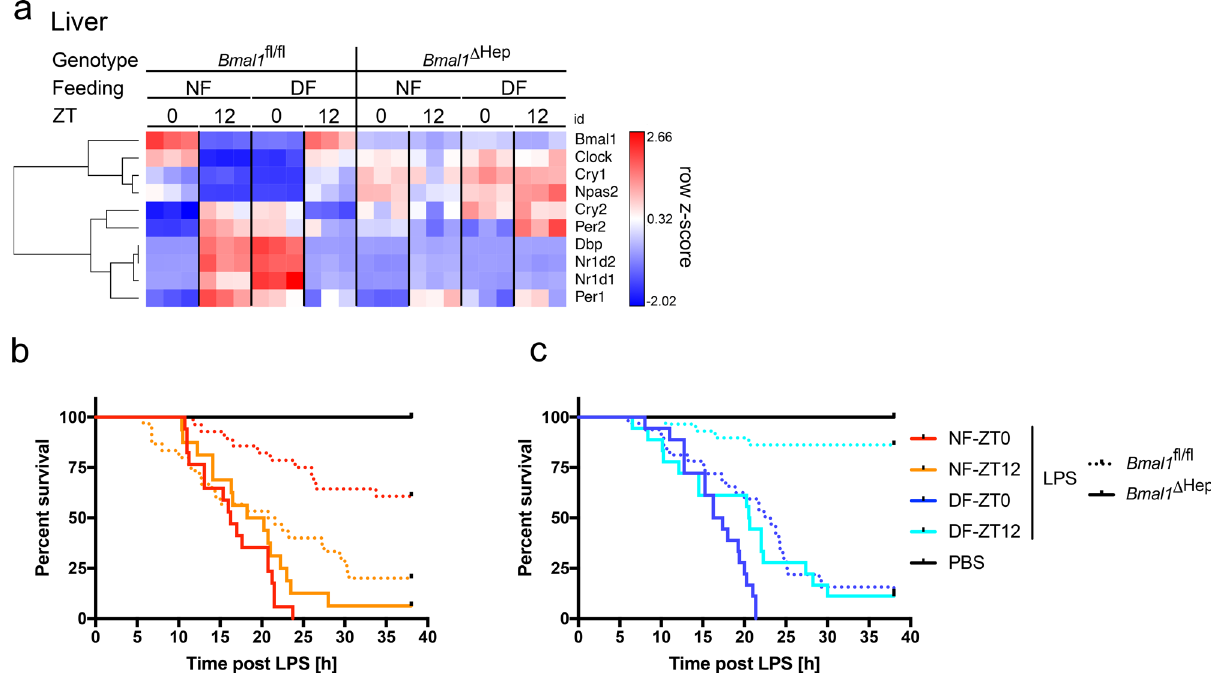
Fig. 4 The liver clock regulates susceptibility to LPS. a Gene expression pro fi le of selected clock genes in liver measured by NanoString in female Bmal1 fl / fl or Bmal1 Δ Hep mice on day 5 of TRF at the indicated times. Unsupervised gene clustering. N = 3. b , c Morbidity in night-time ( b ) or day-time ( c ) Bmal1 Δ Hep solid line (NF 0 vs. 12 ns, DF 0 vs. 12 p = 0.0163, ZT0 NF vs. DF ns, ZT12 NF vs. DF ns) or control Bmal1 - fl oxed (dashed) mice (NF 0 vs. 12 p = 0.0008, DF 0 vs. 12 p < 0.0001, ZT0 NF vs. DF p < 0.0001, ZT12 NF vs. DF p < 0.0001), following 20 mg/kg LPS i.p. on day 5 of TRF at ZT0 or ZT12 as indicated. Statistical analysis according to Mantel – Cox. Experimental numbers: Bmal1 Δ Hep mice: DF-ZT0-LPS N female = 9 N male = 9, NF-ZT0-LPS N female = 9 N male = 8, DF-ZT12-LPS N female = 9 N male = 9, NF-ZT12-LPS N female = 8 N male = 8, DF-ZT0-PBS N female = 3 N male = 3, NF-ZT0-PBS N female = 2 N male = 4, DF-ZT12- PBS N female = 3 N male = 3, NF-ZT12-PBS N female = 2 N male = 4. Bmal1 fl / fl : DF-ZT0-LPS N female = 16 N male = 16, NF-ZT0-LPS N female = 16 N male = 12,